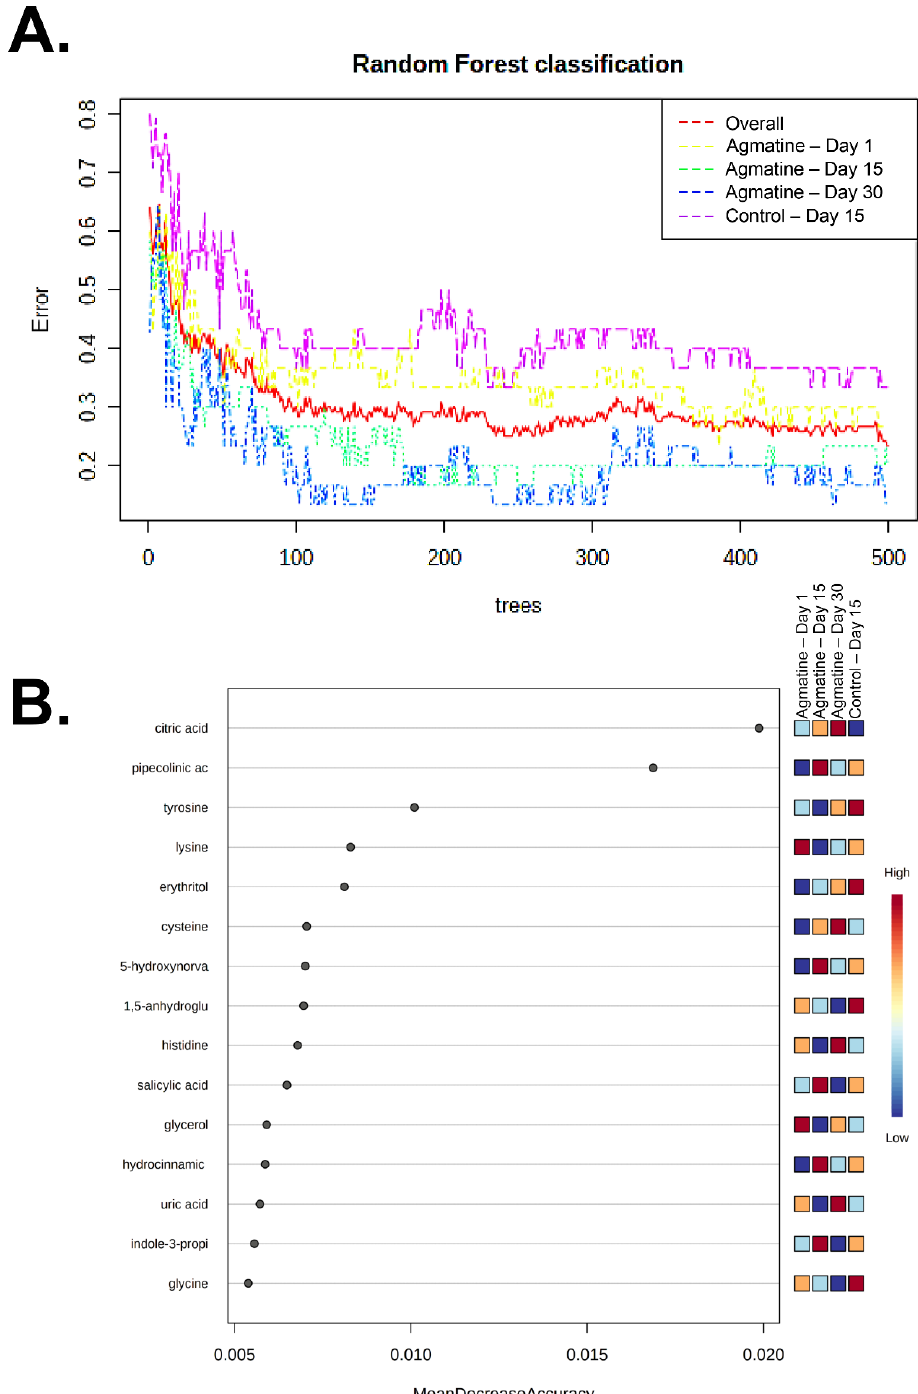
Figure 8. Random forest classification of treatment/time cohorts (agmatine 1st, 15th, 30th day; control 15th day). The total classification error rates of 500 trees are presented for overall (red), 1 (yellow), 15 (green), 30 (blue) days of agmatine and 15 (purple) days of control administration ( A ). A variable importance plot of the association of measured metabolites with each classifying treatment cohort ( B ). The metabolites are presented in decreasing importance, from the highest to the lowest point of the